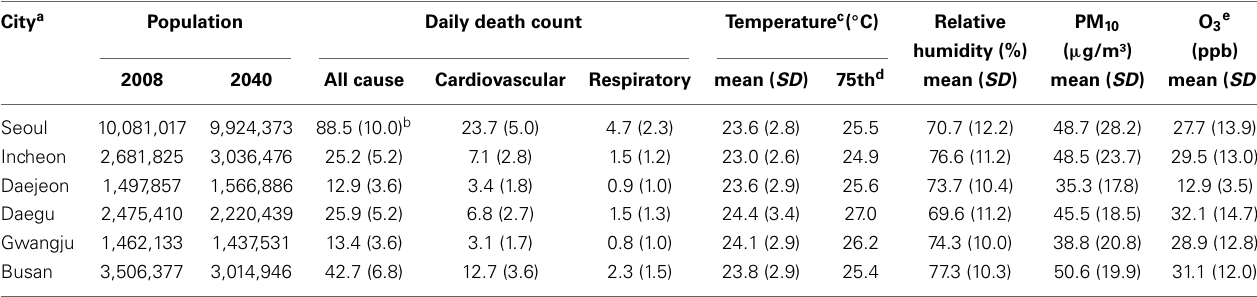
Table 1 | Summary statistics of the study population, weather, and pollution variables of six cities in Korea, 2001–2008, summertime (June through September).